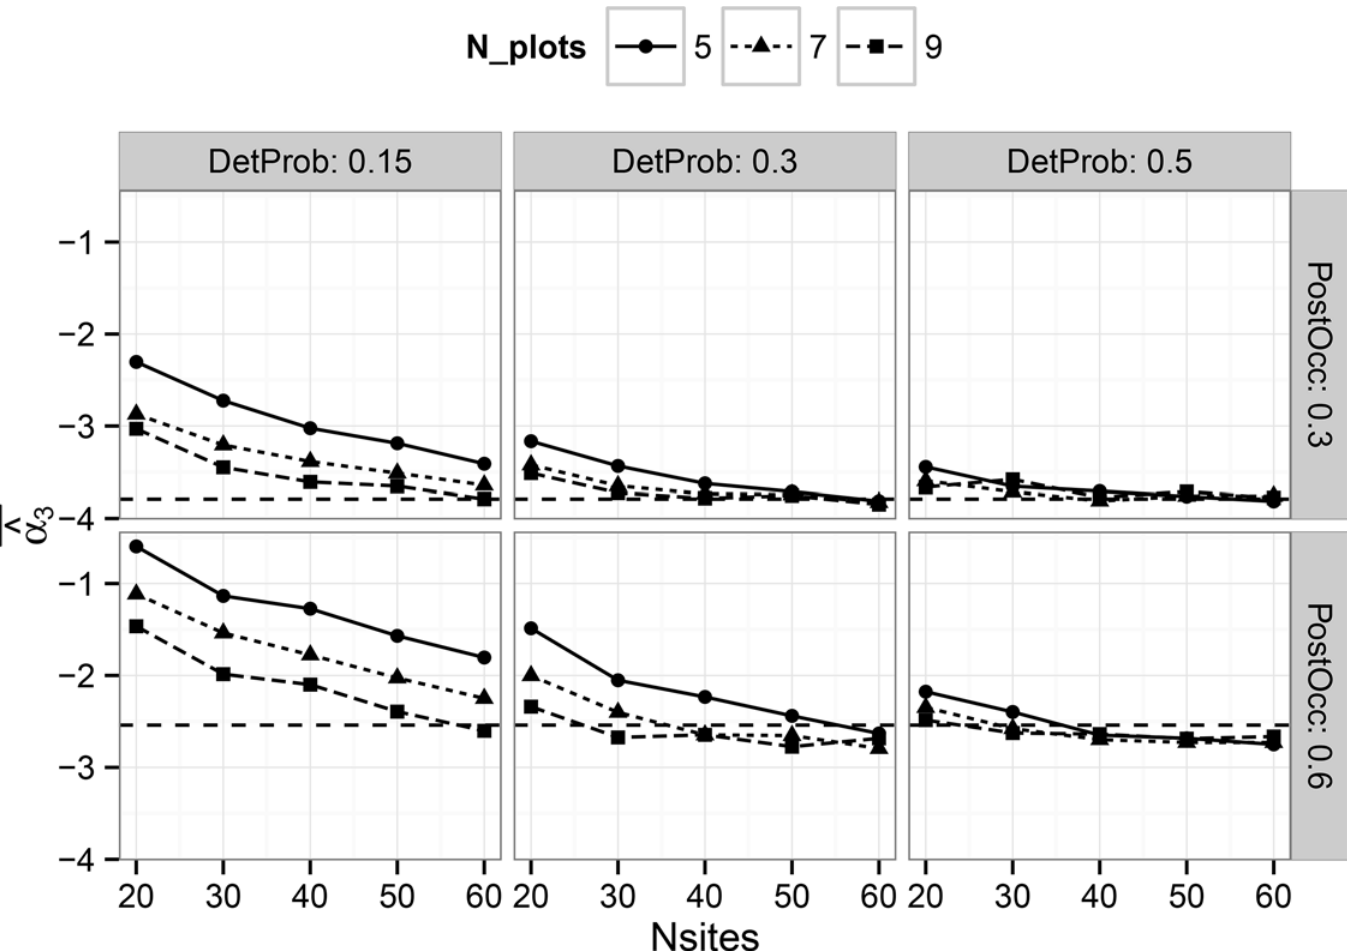
Fig 2. Average, by combination of parameters, of all posterior mean estimates of the treatment effect estimator ‘ Alpha3 ’ (see Eq 2) in the multi- scale occupancy model. Results are shown on the logit scale. Panels show the results for different combinations by simulated detection probability and post-treatment occupancy. Horizontal dashed lines show the true coefficient